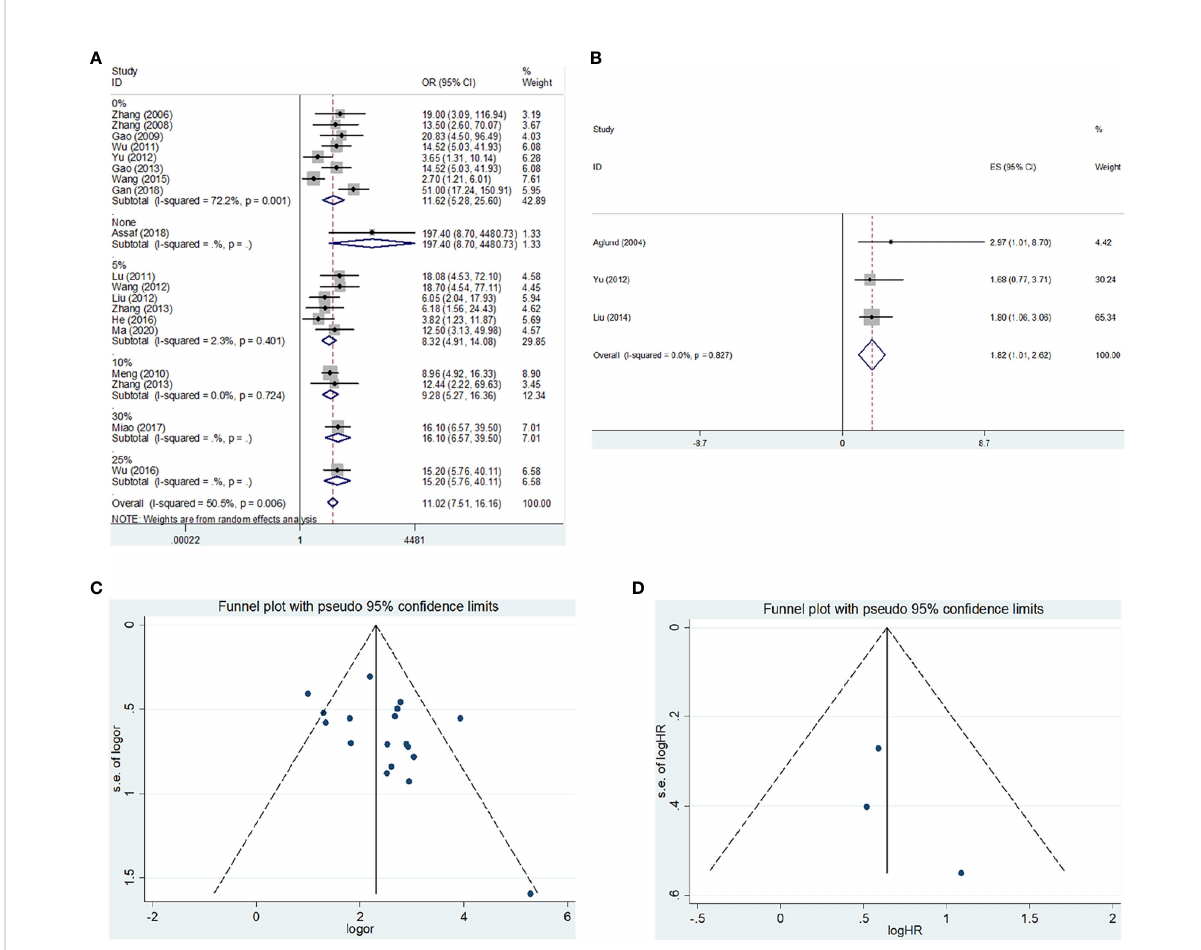
FIGURE 2 The forest plot and funnel plots for the correlations of MMP-9 overexpression with risk and prognosis of EC. (A) Forest plot for the risk of EC. (B) Forest plot for the overall survival of EC. (C) Funnel plot for the risk of EC. (D) Funnel plot for the overall survival of EC. OR, odds ratio; HR, hazard ratio; EC, endometrial